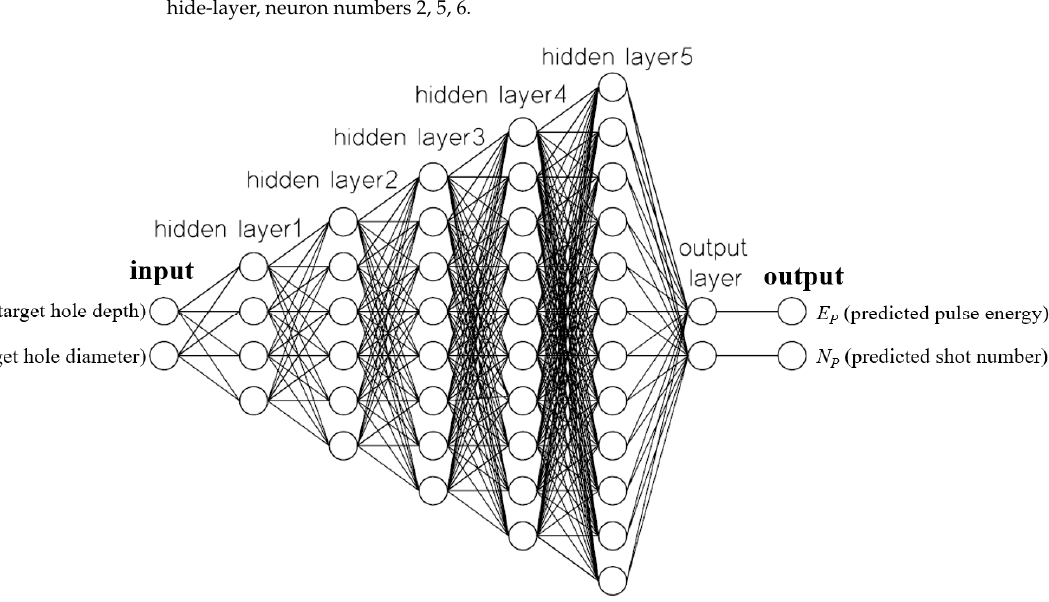
Table 4. Neural network five-fold cross-validation